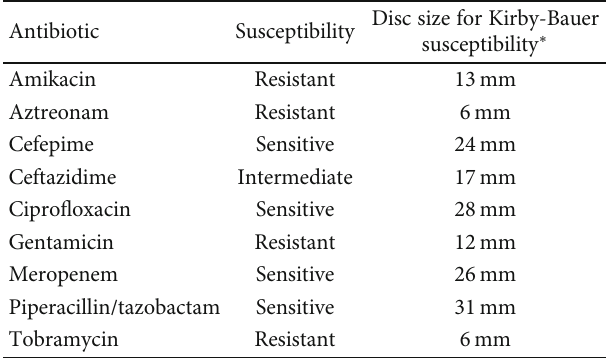
Table 1: Susceptibility pro fi le for Chryseobacterium indologenes .